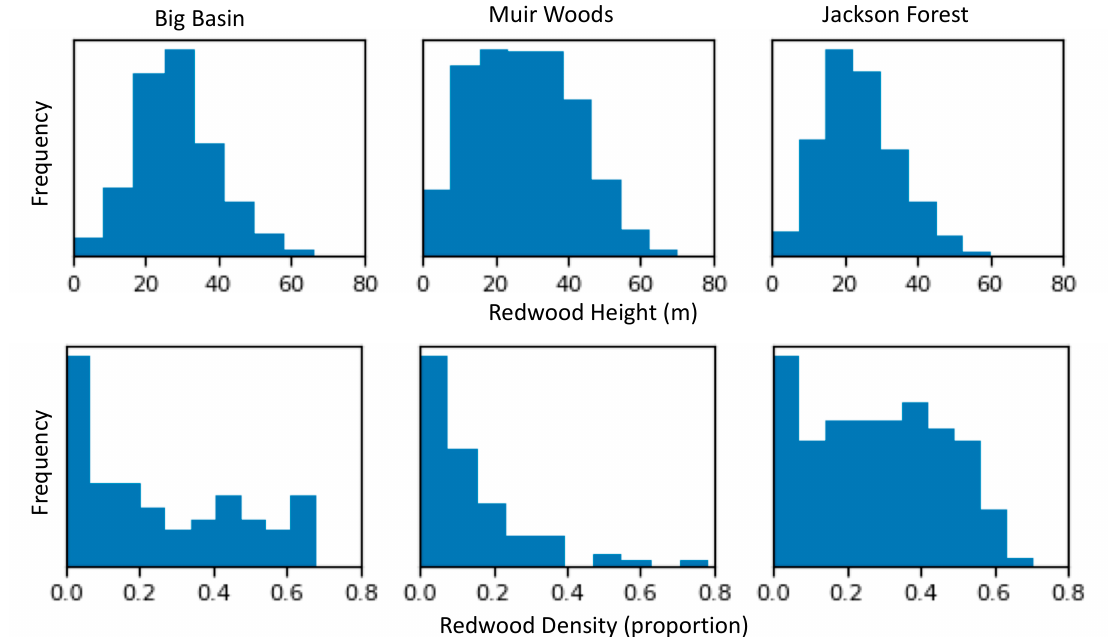
Figure 5. Distributions of redwood height ( top panel ) and redwood density ( bottom panel ) at all three sites. Redwood height was calculated as the maximum height in a ten meter radius with a redwood in it; redwood density was calculated as the proportion of redwood detections within a 1-square kilometer aggregation block.